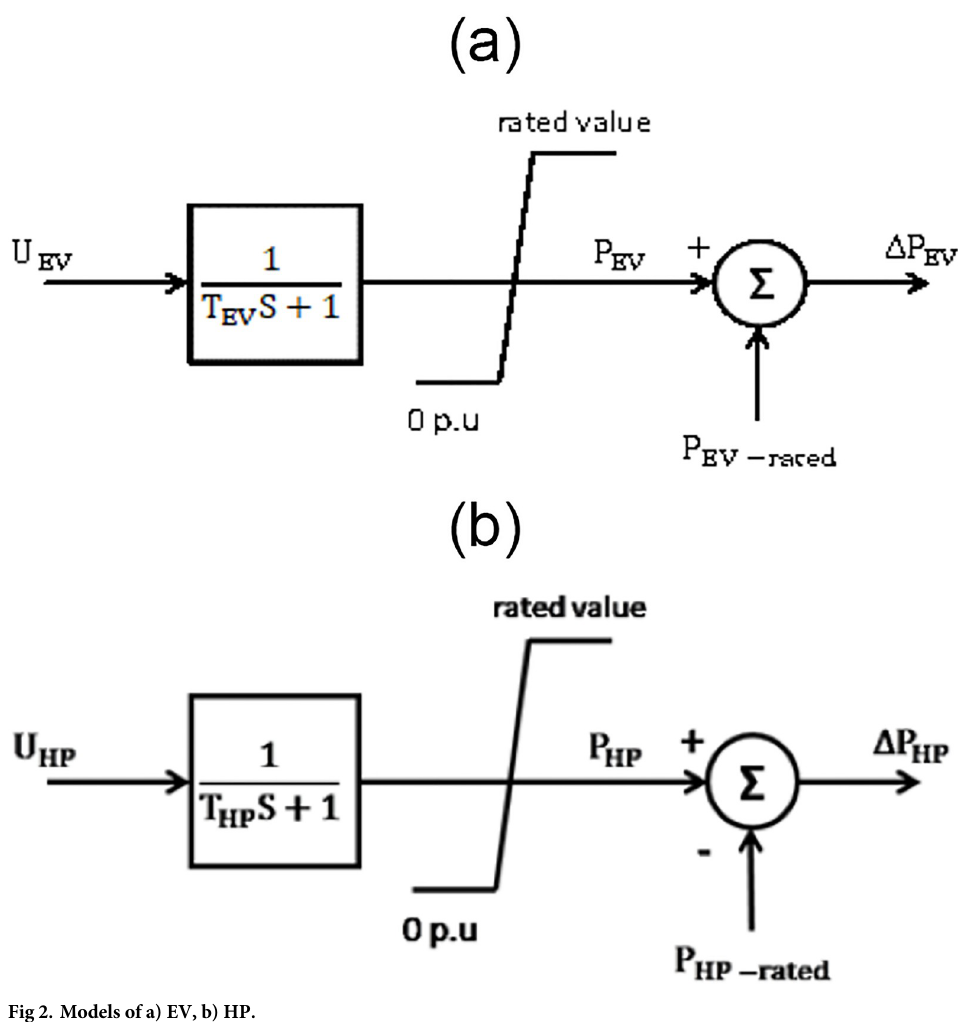
Fig 2. Models of a) EV, b)